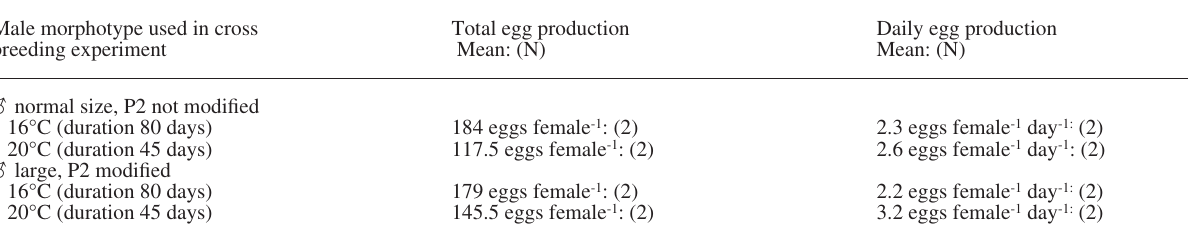
Table 2. – total egg production rates and mean daily egg production rates in the two